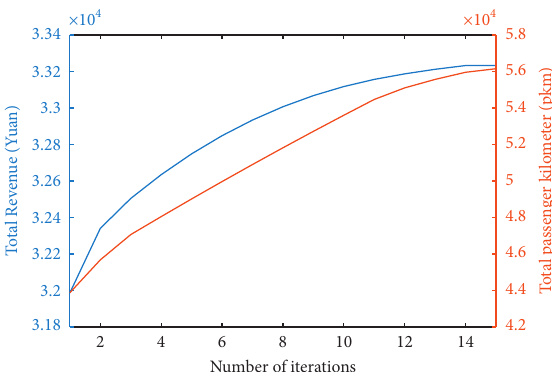
Figure 4: Optimization process curves of small-scale numerical instance.